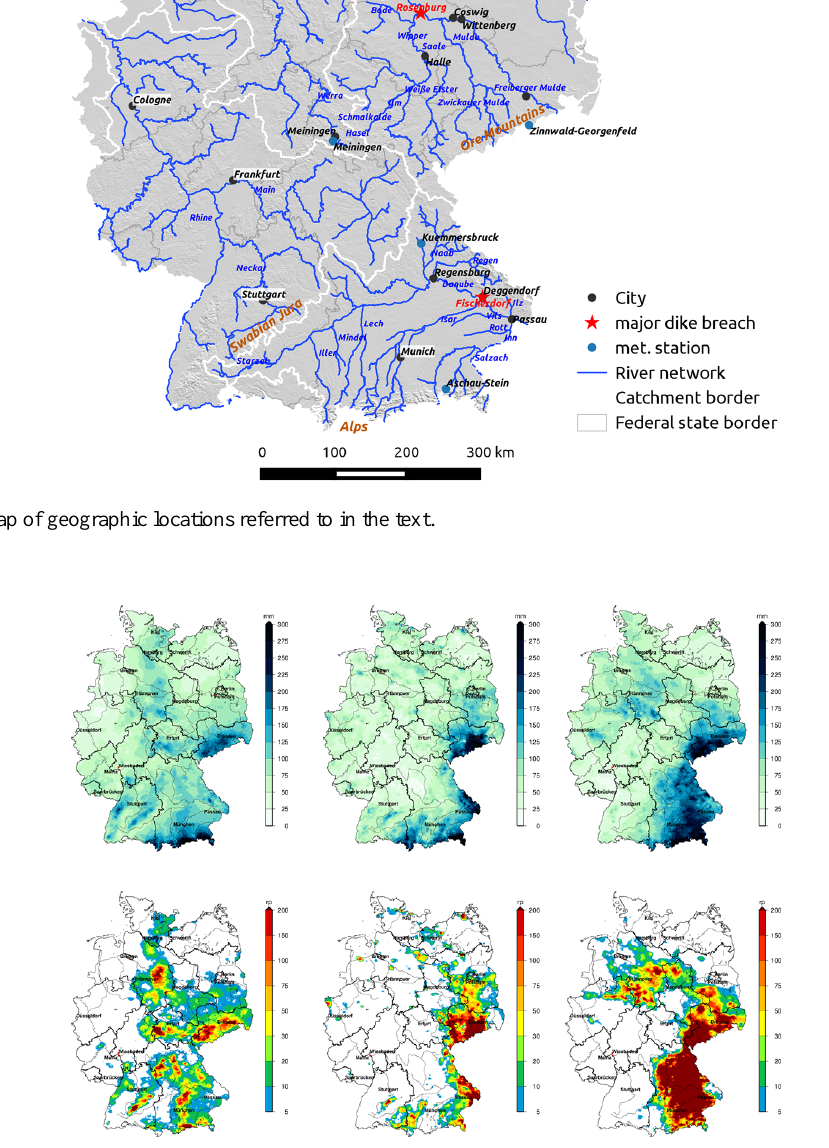
Figure A2. As Figs. 4 and 6, but for 7-day maximum precipitation (top line: 7-day maximum precipitation; bottom line: return periods – June 2013, left; August 2002, middle; July 1954,